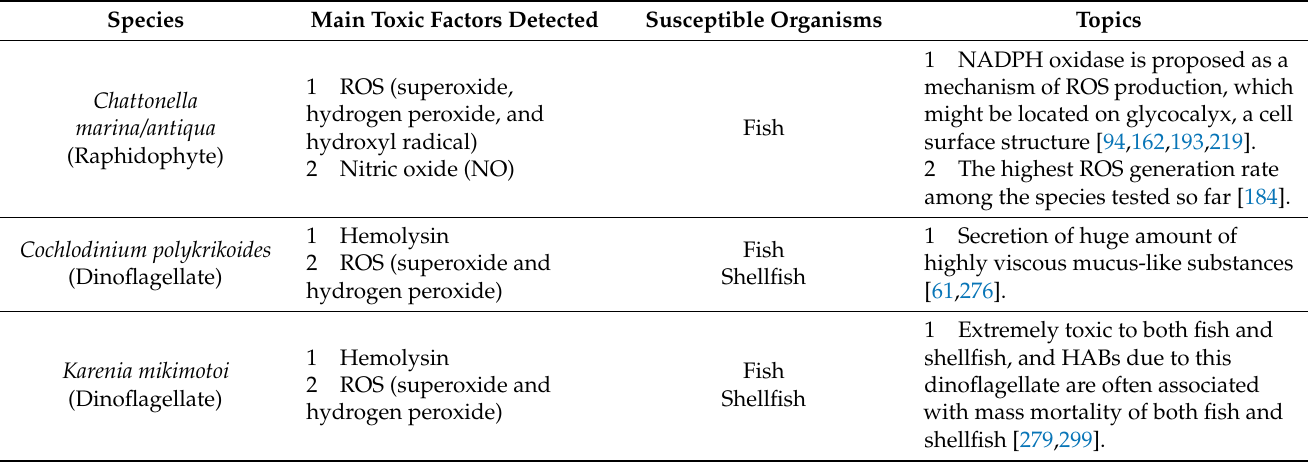
Table 4. The most harmful and notable HAB-forming species highlighted in this